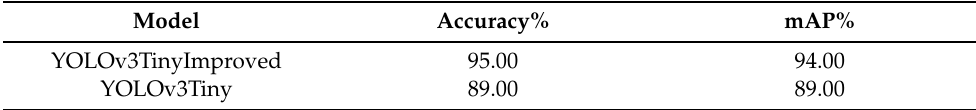
Table 3. Both models results with comparison.